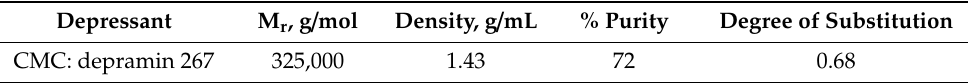
Table 4. Properties of the selected sodium carboxymethyl